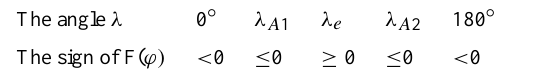
Table 2. Characteristic values of propagation angles of MHD waves behind a fast shock wave and the corresponding signs of function F( ϕ) . The angle